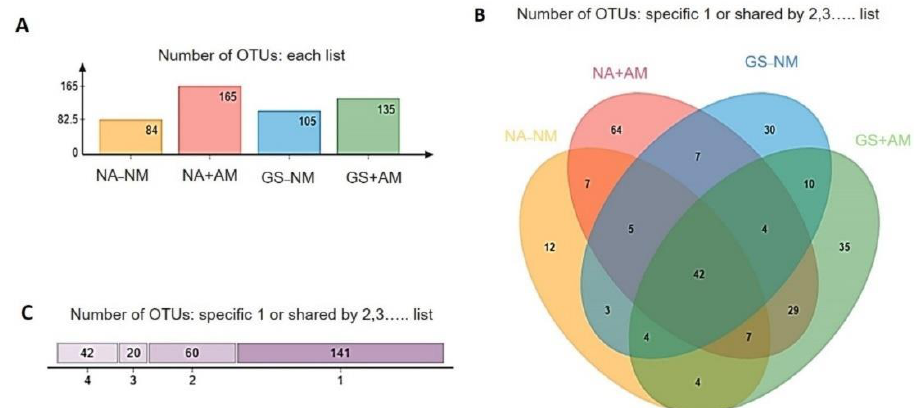
Figure 4. A Venn diagram displaying the degree of overlap or OTUs based co-occurrence of AMF (at the 3% evolutionary distance) among the four treatments. NA-NM: Non-amended Non-mycorrhizal inoculation; NA+AM: Non-amended Mycorrhizal Inoculation; GS-NM: Garlic stalk amended with Non-mycorrhizal inoculum; GS+AM: Garlic stalk amended with mycorrhizal inoculum. Total number of OTUs in each group ( A ), overlapping fashion among all soil samples ( B ), and specific and shared OTUs ( C ) among treatments.